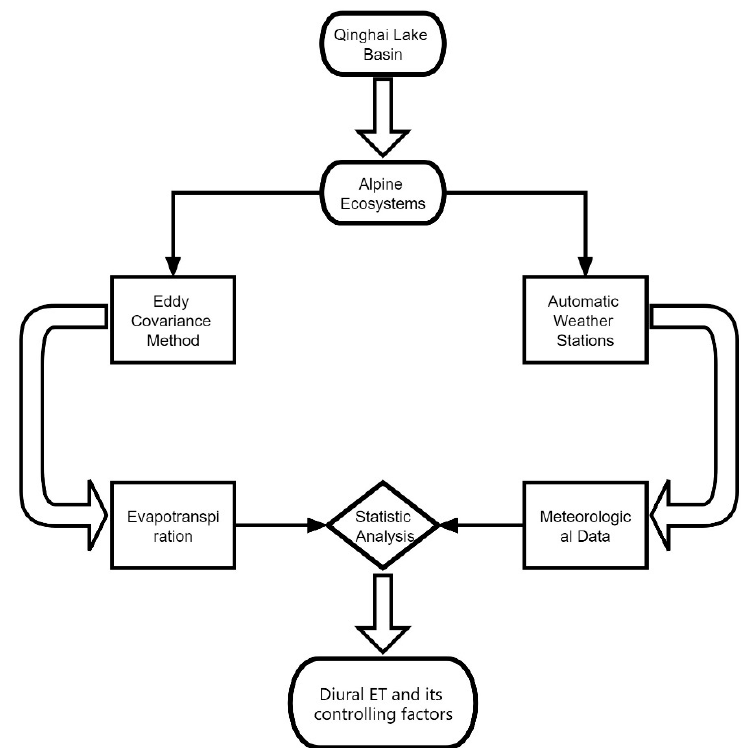
Figure 2. The flowchart of this study. Based on the half-hourly eddy covariance and micrometeoro- logical data of four alpine ecosystems of the growing season (from May to September) in 2019 over Qinghai Lake Basin, their diurnal ET is quantified, and their influencing factors are identified during daytime and nighttime by statistical analysis method.